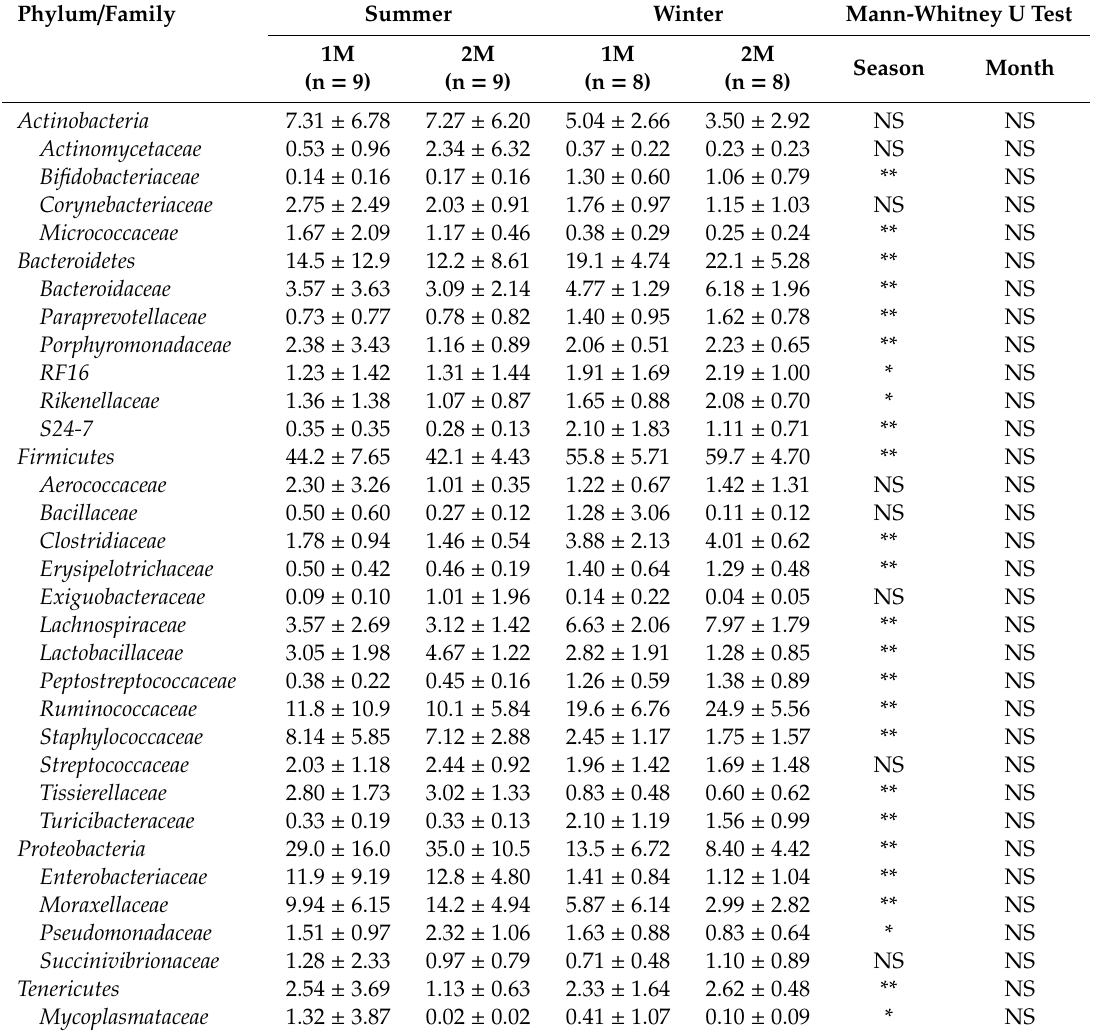
Table 2. Relative abundance (%) of uterine microbiota of the dairy cows examined at one and two months postpartum during the two